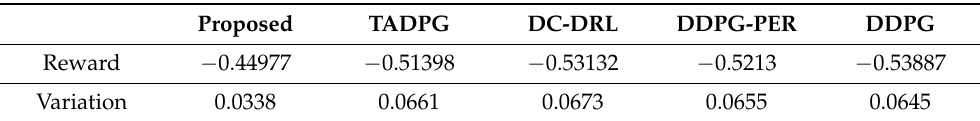
Figure 5. Normalized reward comparison. Table 2. Reward and variation